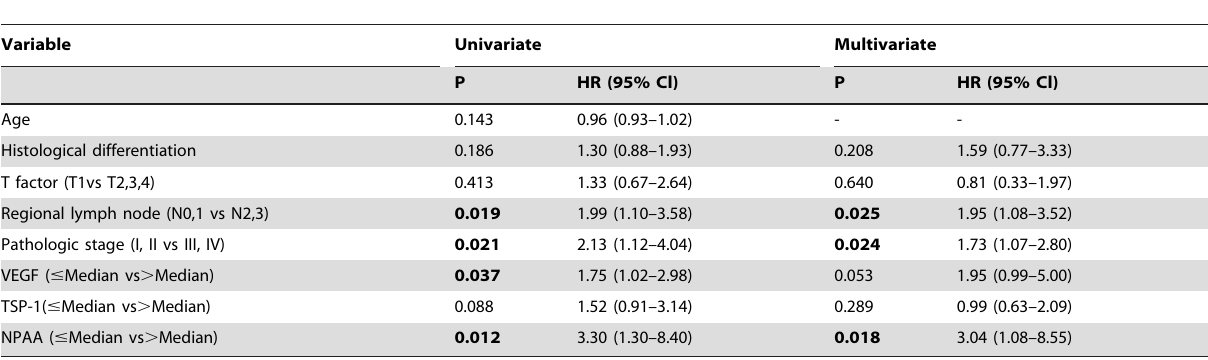
Table 3. Cox Regression Analysis for Overall Survival in 68 Patients with Lung Cancer.